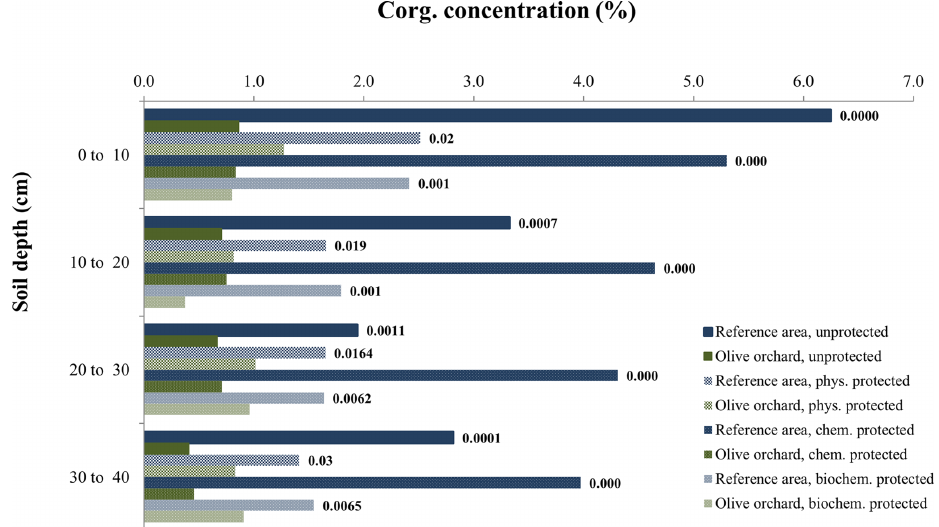
Figure 3. Organic carbon concentration in the different soil organic carbon fractions at each depth, comparing the reference site vs. olive orchard. The labels of the bars indicate the p value according to a one-way ANOVA comparing treatments for the same soil depth and carbon fraction between the reference area and olive